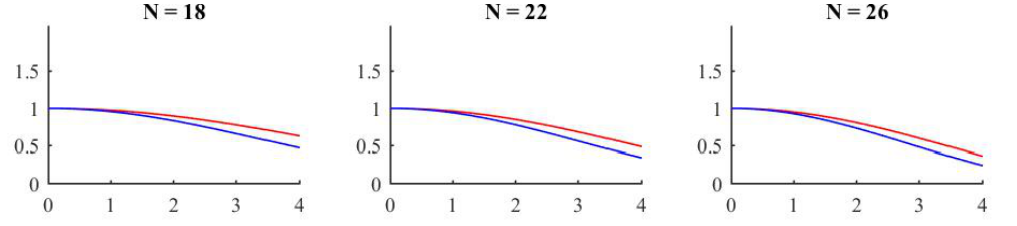
Figure 27 . We compare the expectation value of h S 1 ( t ) S 1 (0) i in the thermal state (blue) and pure state (red).